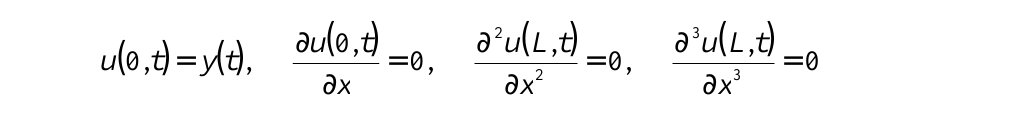
is the absolute tip motion and (x,t) (t)